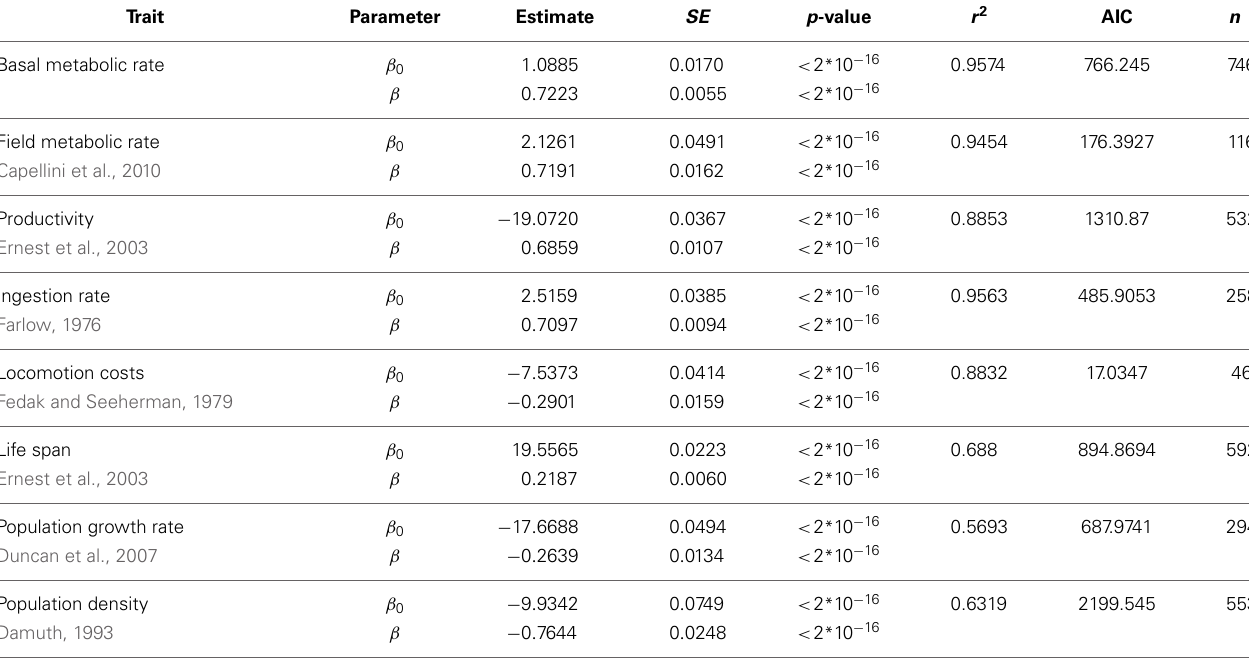
Table 2 | Fit of the data in Figure 1 of the main text using a linear ( ln ( Trait ) ∼ β 0 + β ln ( M ))